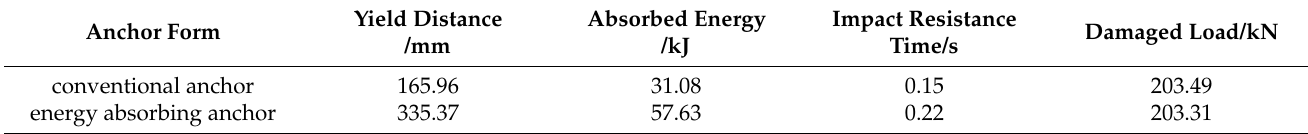
Table 6. Comparison of mechanical properties of conventional anchor and energy absorbing